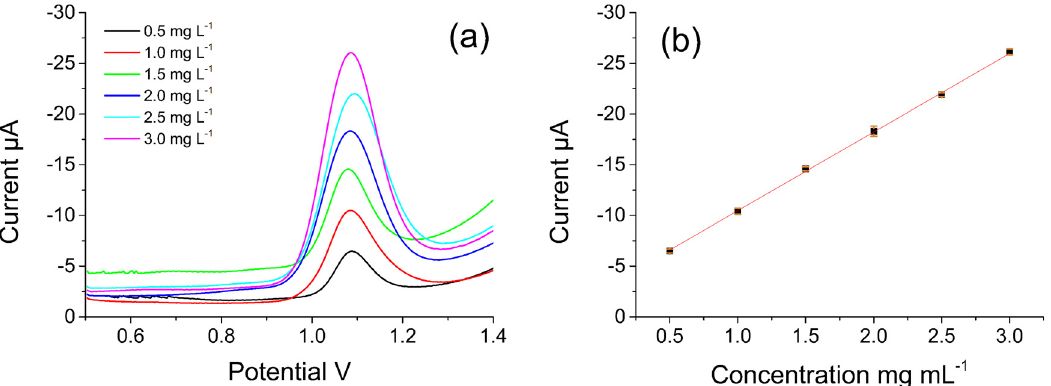
Figure 4: ( a ) The oxidation peak current of G/PTH/NG/GCE after incubation in Fenton solution with di ff erent concentration of ascorbic acid ( a – i ) : 0.5, 1.0, 1.5, 2.0, 2.5 and 3.0 mg L − 1 . ( b ) The calibration plot of oxidant peak current against the concentration of ascorbic